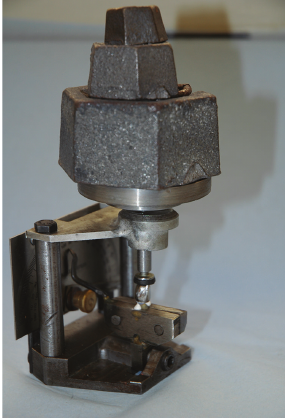
Figure 4: Specimens of post and core fabricated with wax patterns.